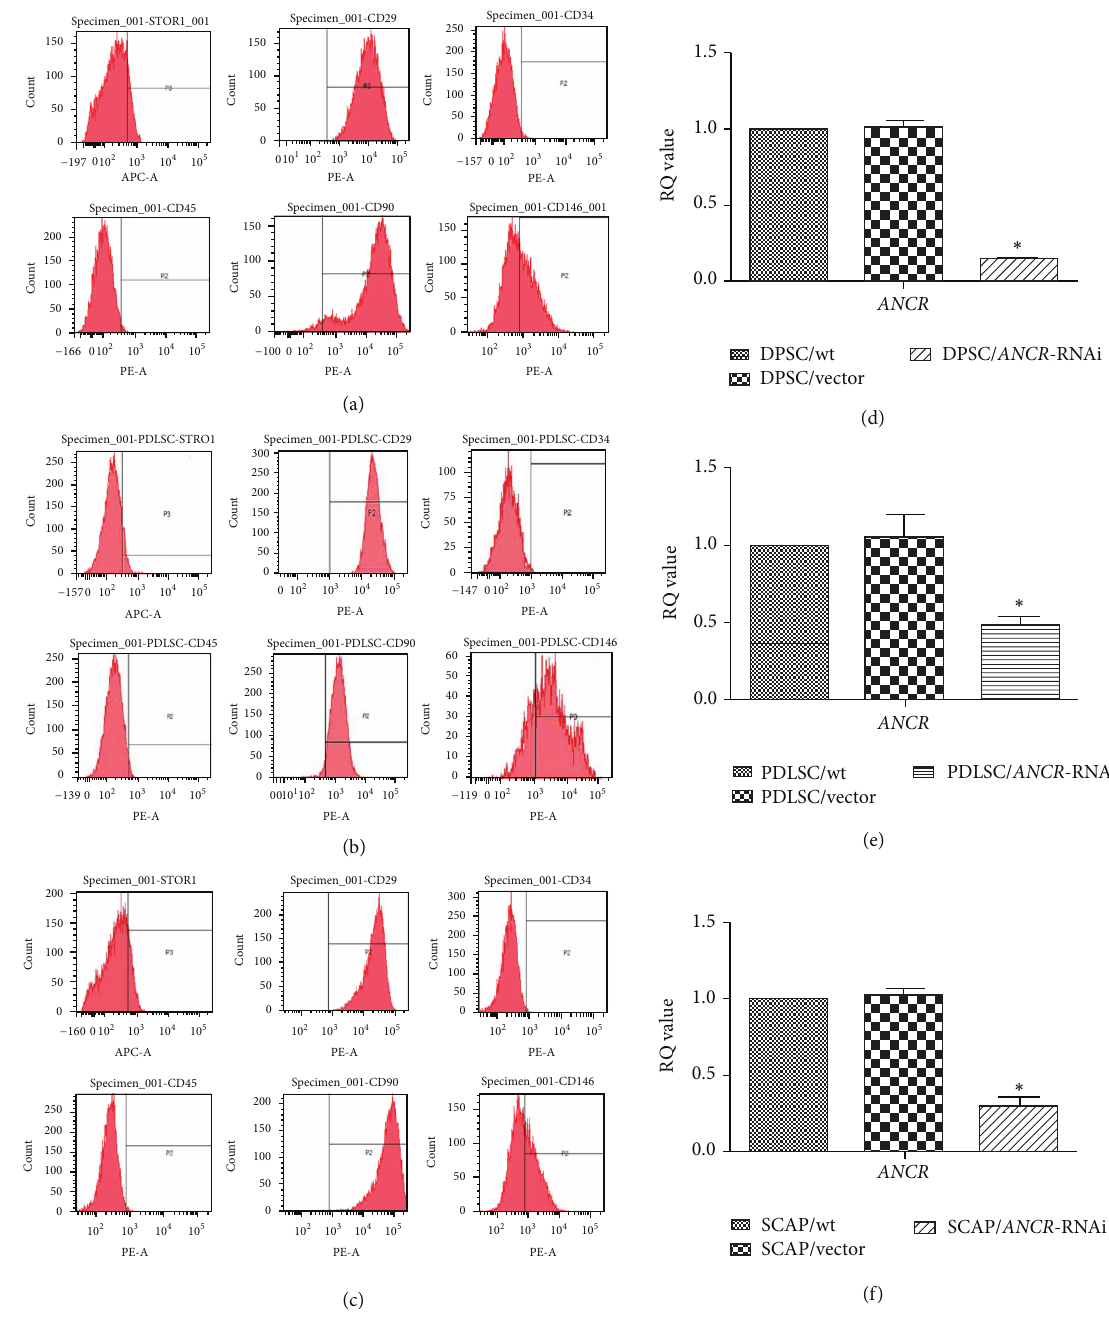
Figure 1: The characterization and ANCR interference of DTSCs. The DPSCs (a), PDLSCs (b), and SCAP (c) that we isolated expressed mesenchymal stem cell markers, including CD29, CD90, CD146, and STRO-1 , but were negative for the hematopoietic cell marker CD34 and leukocyte marker CD45 . Three days after lentivirus infection, we evaluated the effects of ANCR -RNAi by Q-PCR. The results showed that ANCR expression in DPSC/ ANCR -RNAi (d), PDLSC/ ANCR -RNAi (e), and SCAP/ ANCR -RNAi (f) cells was remarkably downregulated when compared with control cells. ∗ 𝑃 < 0.05 when compared with the control group.